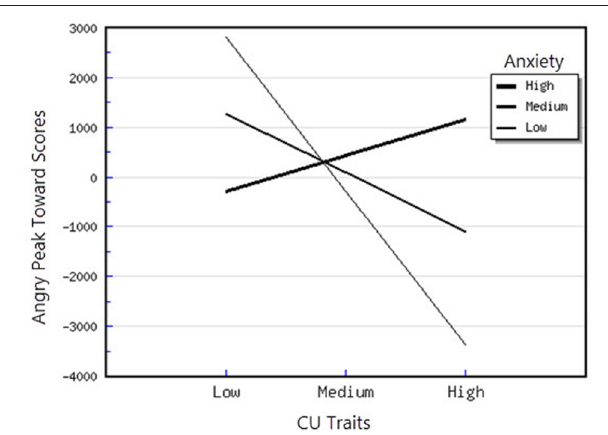
FIGURE 1 | Interaction between ODD problems and CU traits in predicting angry peak away scores.